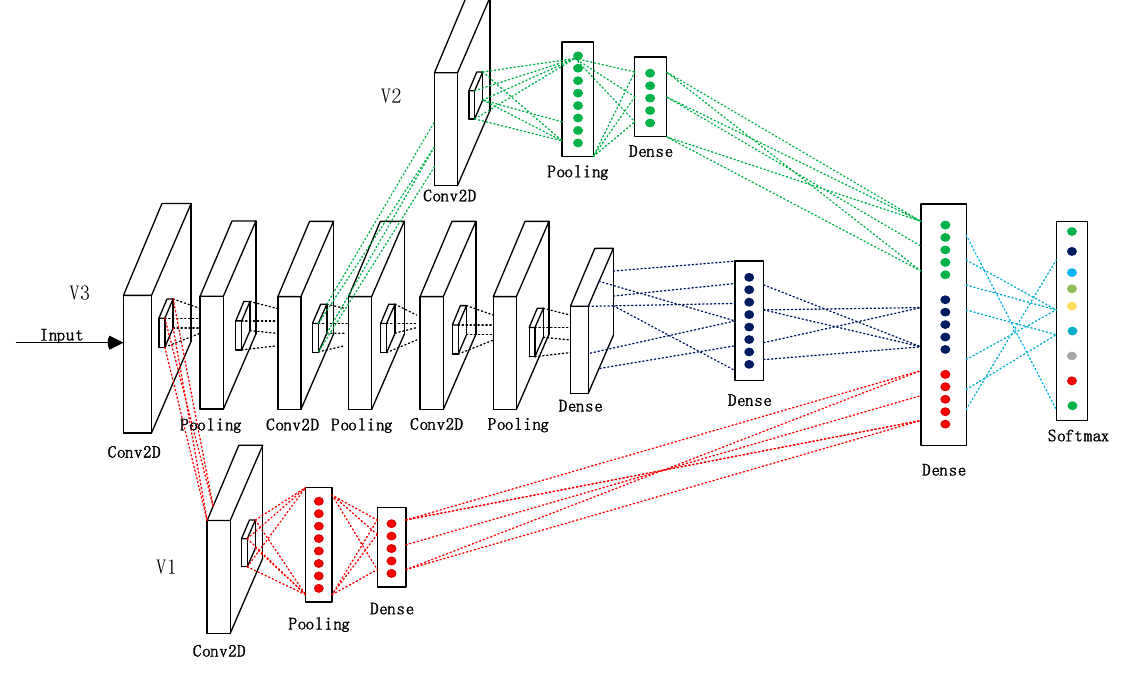
Figure 1. C-c CNN structure.